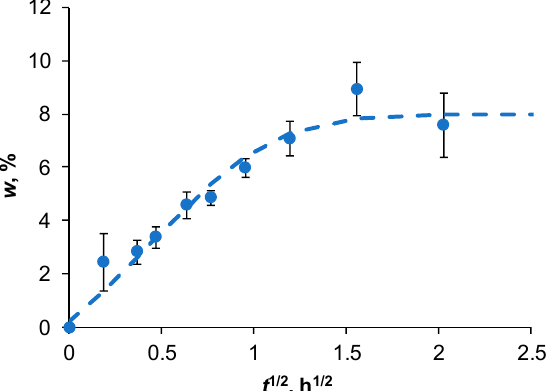
Figure 3. Weight gain of pure NFC film under RH 98%, 22 °C. Line is approximation by the Fick’s model, Equation (3).